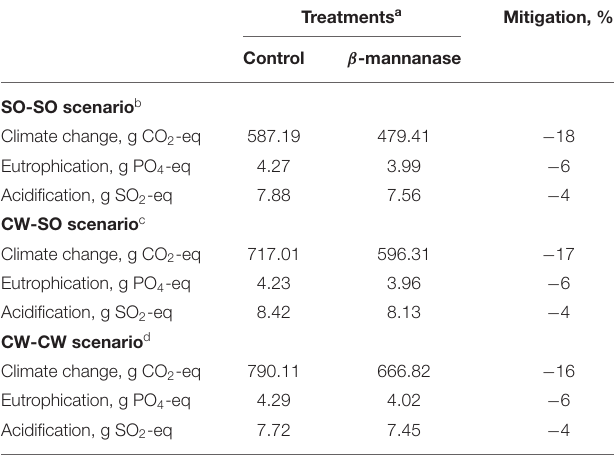
kg of feed, with β -mannanase supplemented diets compared to control